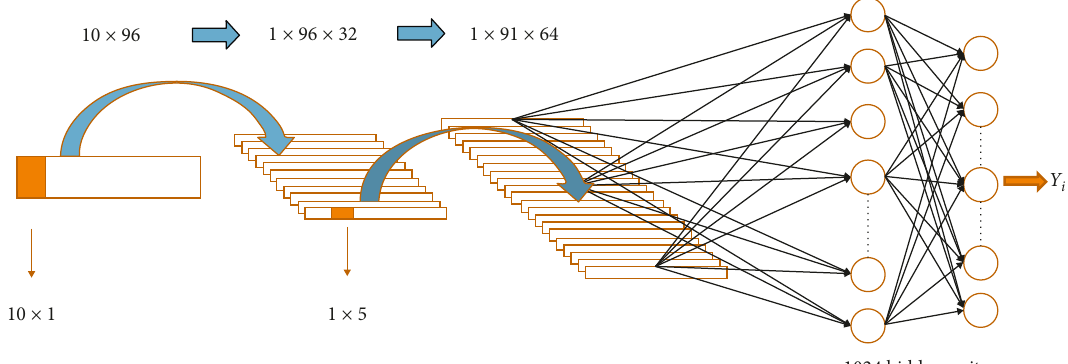
Figure 6: Deep CNN architecture for damage localization and quantification.